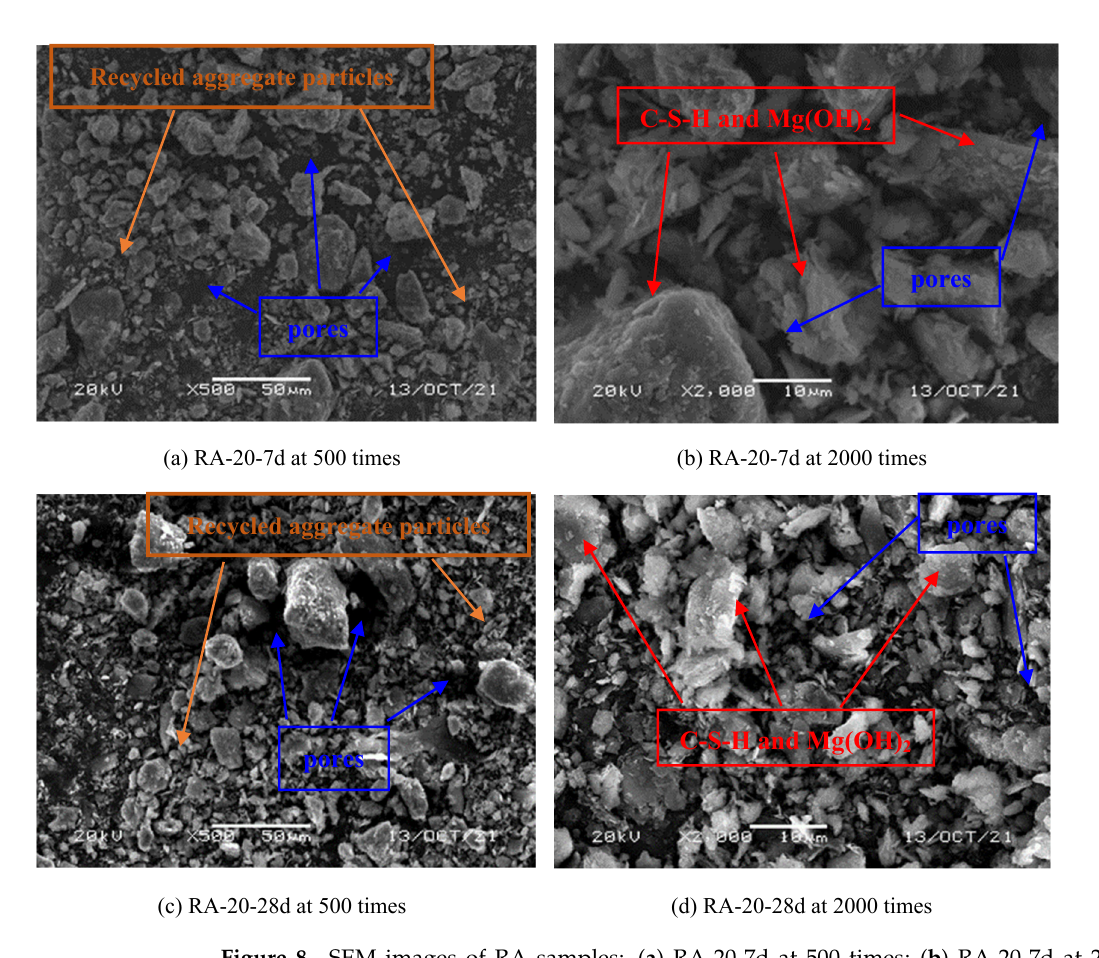
Figure 8. SEM image of RA sample: (a) RA-20-7d at 500 times; (b) RA-20-7d at 2000 times; (c) RA- 360 Figure 8. SEM images of RA samples: ( a ) RA-20-7d at 500 times; ( b ) RA-20-7d at 2000 times; 20-28d at 500 times; (d) RA-20-28d at 2000 times. 361 ( c ) RA-20-28d at 500 times; ( d ) RA-20-28d at 2000